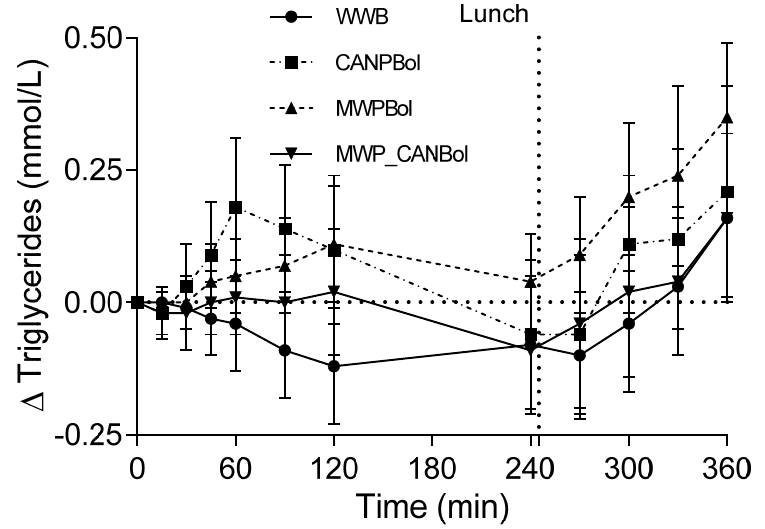
Figure 3. Mean (±SEM) changes in triglyceride response after the intake of the test meals and reference meal, and a subsequent standardized lunch (Study 2).